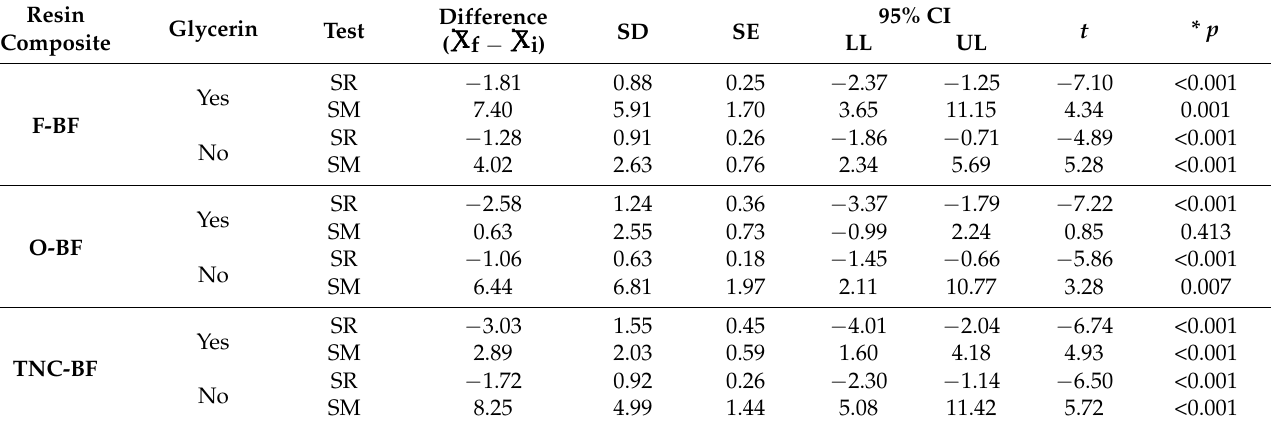
Table 6. Comparison of microhardness (HV) and surface roughness (µm) variation, before and after polishing, between bulk-fill resin composites with and without OIL control. Table 5. Comparison of surface roughness (µm) and microhardness (HV) between before and after polishing of bulk-fill resin composites with and without OIL control.